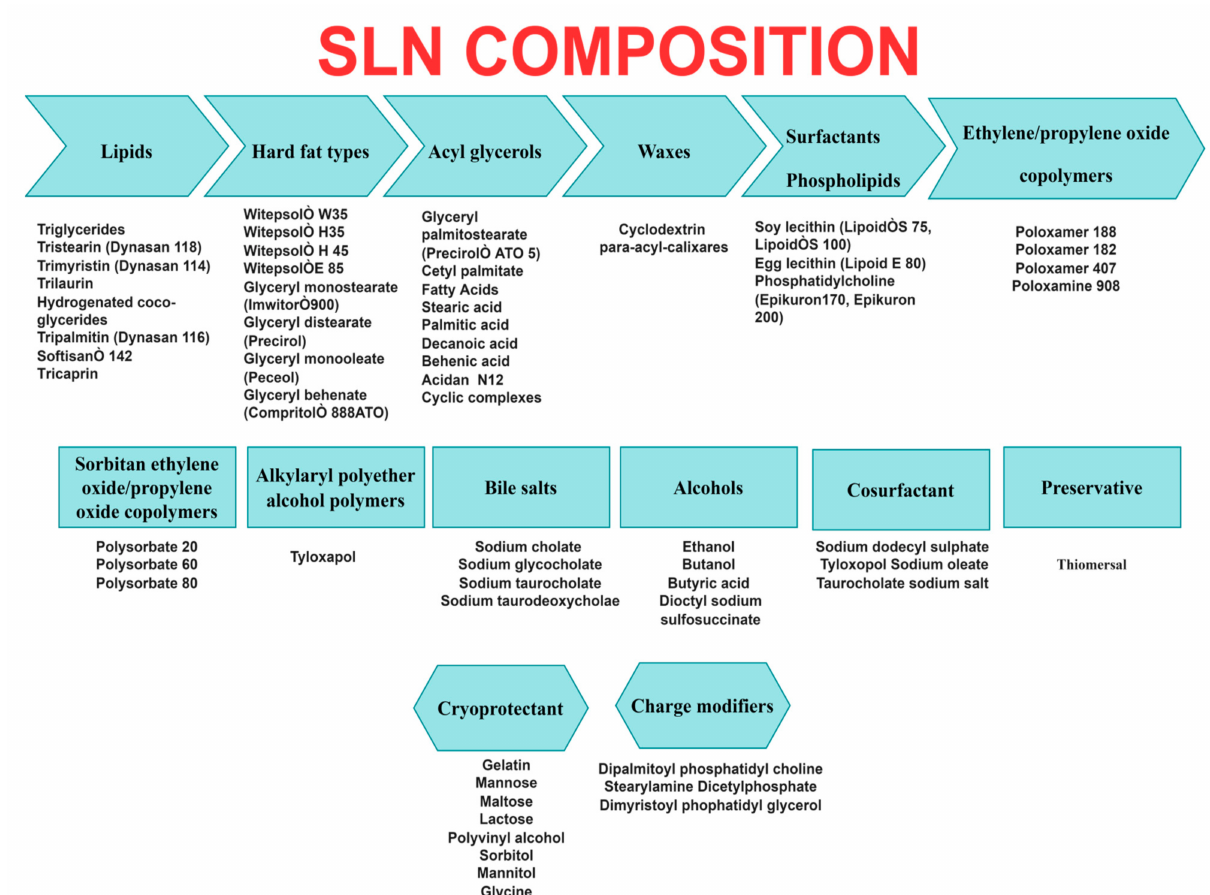
Figure 2. Ingredients used in SLN